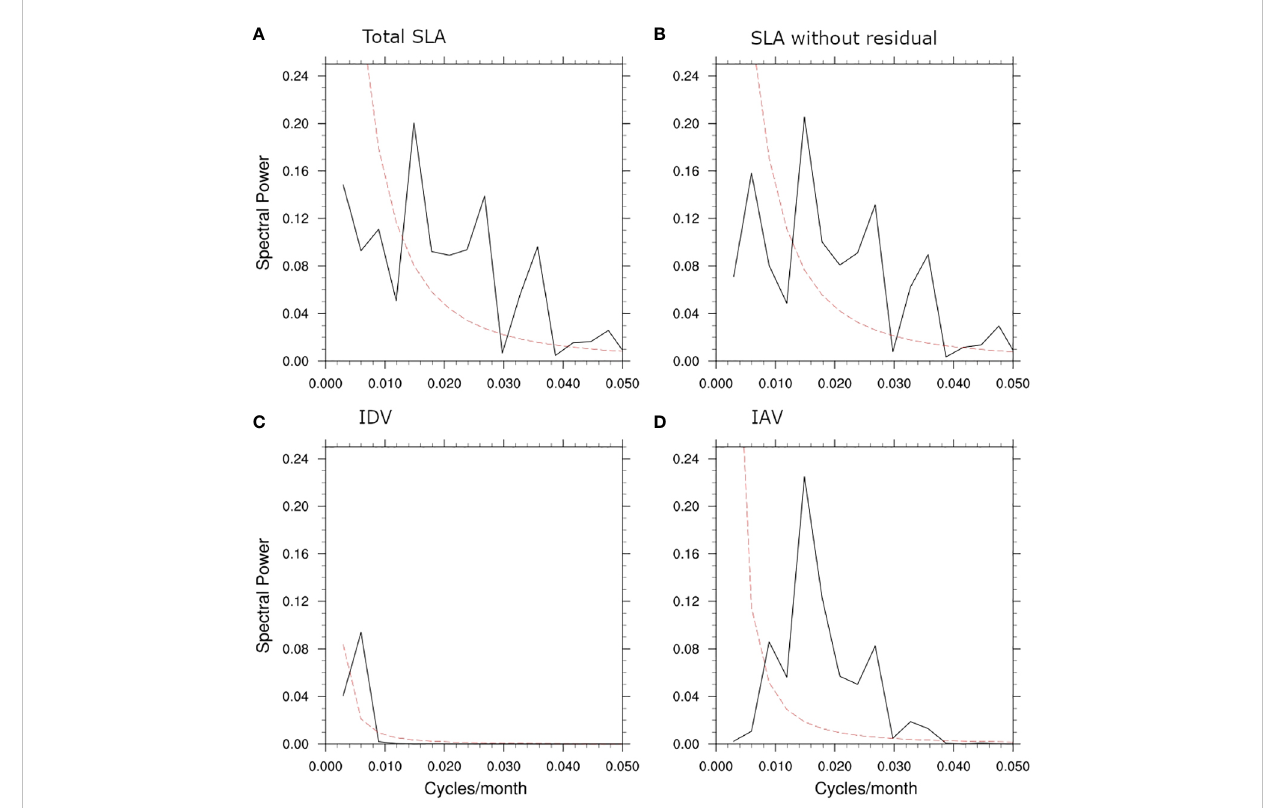
FIGURE 5 The power spectra of SLA over the NWP region for different cases. (A) Total SLA, (B) SLA after the removal of residual, and (C, D) for the interdecadal and interannual SLA. The dashed line (red) indicates the red noise spectra.